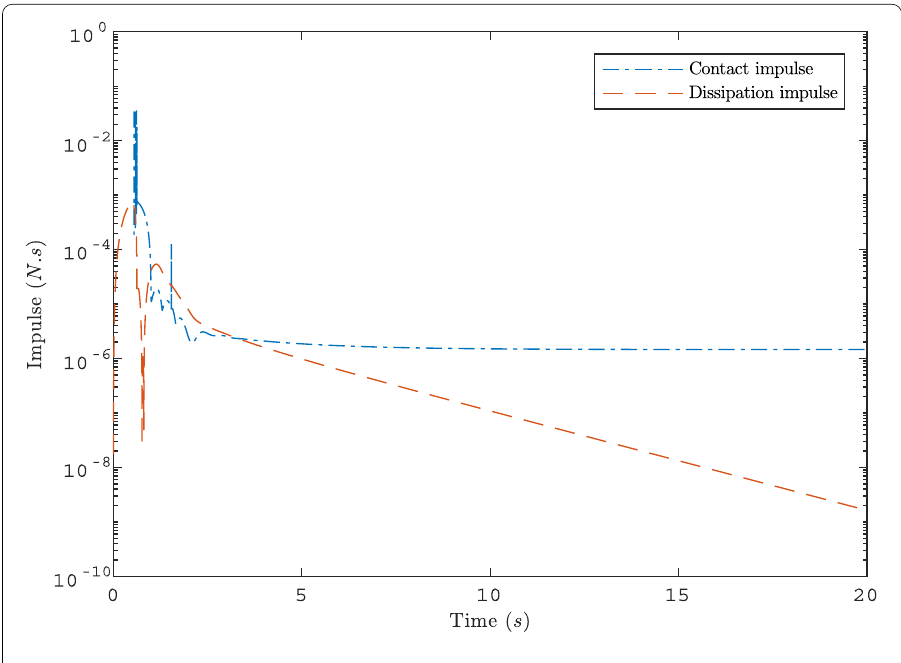
Fig. 25 Discrete arch—impulse evolutions for mass scaling convergence criteria